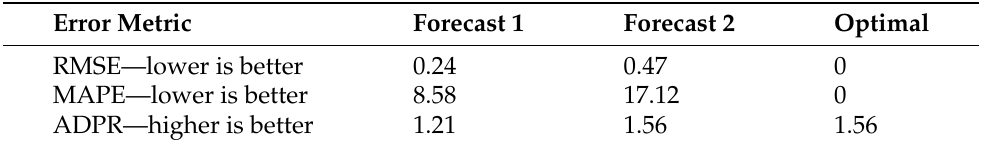
Figure 4. Two example electricity demand forecasts (units in MW) with data points for every half- hour of 3 days (144 in total). The forecast in the panel on the left has lower standard error metrics and is generally considered better for many applications. However, in our case of battery discharge scheduling, the forecast in the panel on the right is actually better. This is because it better follows the shape of the profile during the 3 afternoon peak times (shown between the vertical bars). The results can be seen in Table 1. Table 1. Error metrics from Forecast 1 and Forecast 2. RMSE and ADPR units are in MW and MAPE is a percentage. ADPR is the Average Daily Peak